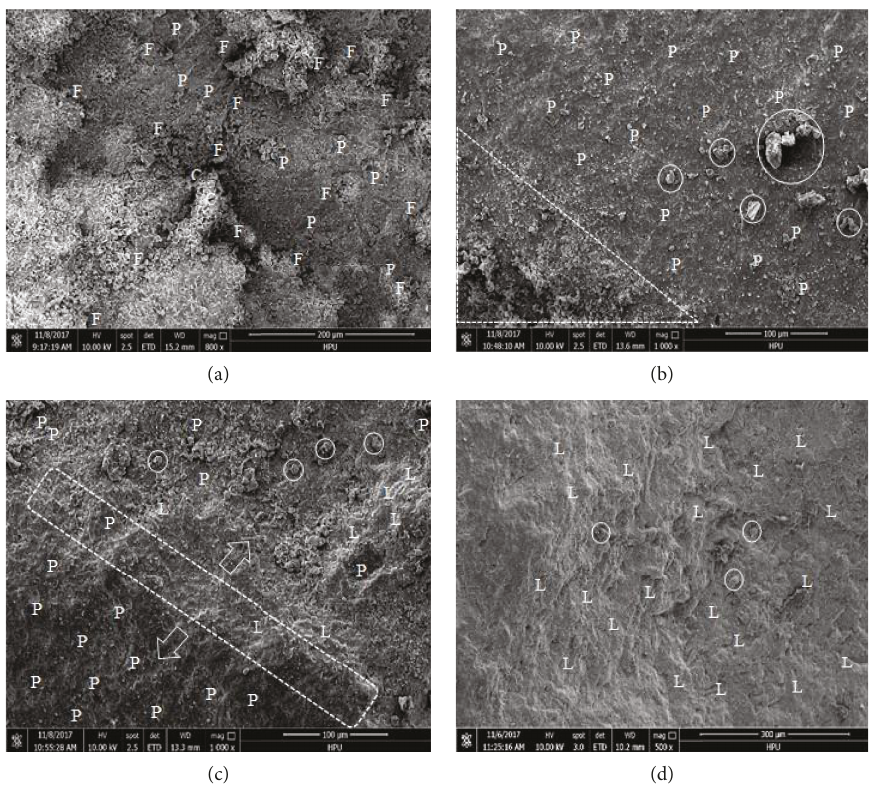
Figure 11: SEM images of the eroded limestone